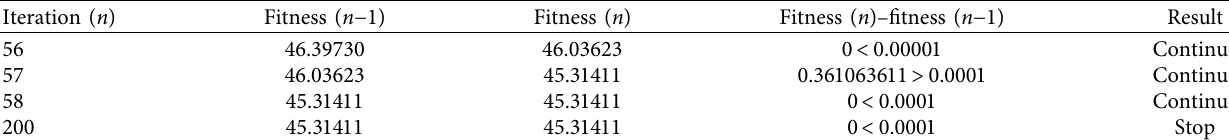
Table 6: Detailed optimization calculation process.